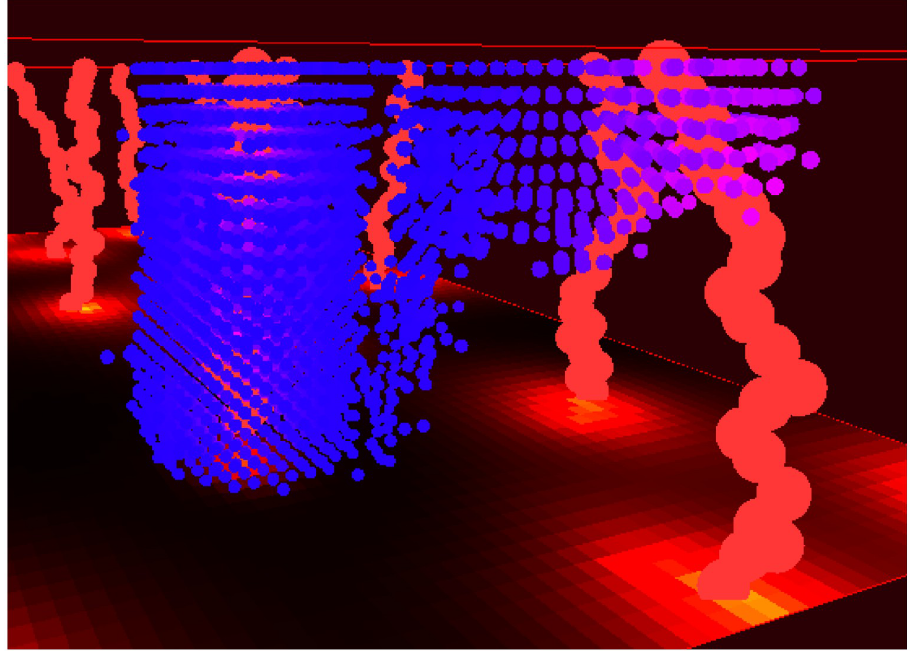
Fig 3. An example of a 3D on-lattice hybrid model of tumor cells spreading through tissue (located in Examples/ 5Example3D). The light red vertical lines represent vessels, and the blue dots represent tumor cells. The cell color goes from pink to blue depending on how much oxygen is locally available. The oxygen availability is also indicated via a heatmap on the floor of the display. With a cell radius of 10 μ m, the domain has dimensions 1.6 × 1.6 × 0.4 mm. Displayed using the OpenGL3DWindow